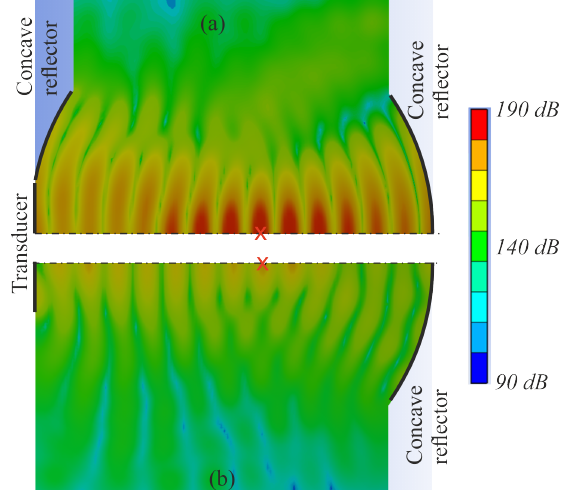
Figure 9. Sound field pattern of a system with concave reflector on both sides (both R = 72 mm) at a resonant distance of L = 117.5 mm ( a ) and for a system with single concave reflector ( R = 72 mm) at a resonant distance of L = 118 mm ( b ); maximum pressure level points marked with x; f = 21.4 kHz; ˆ x = 19 µ